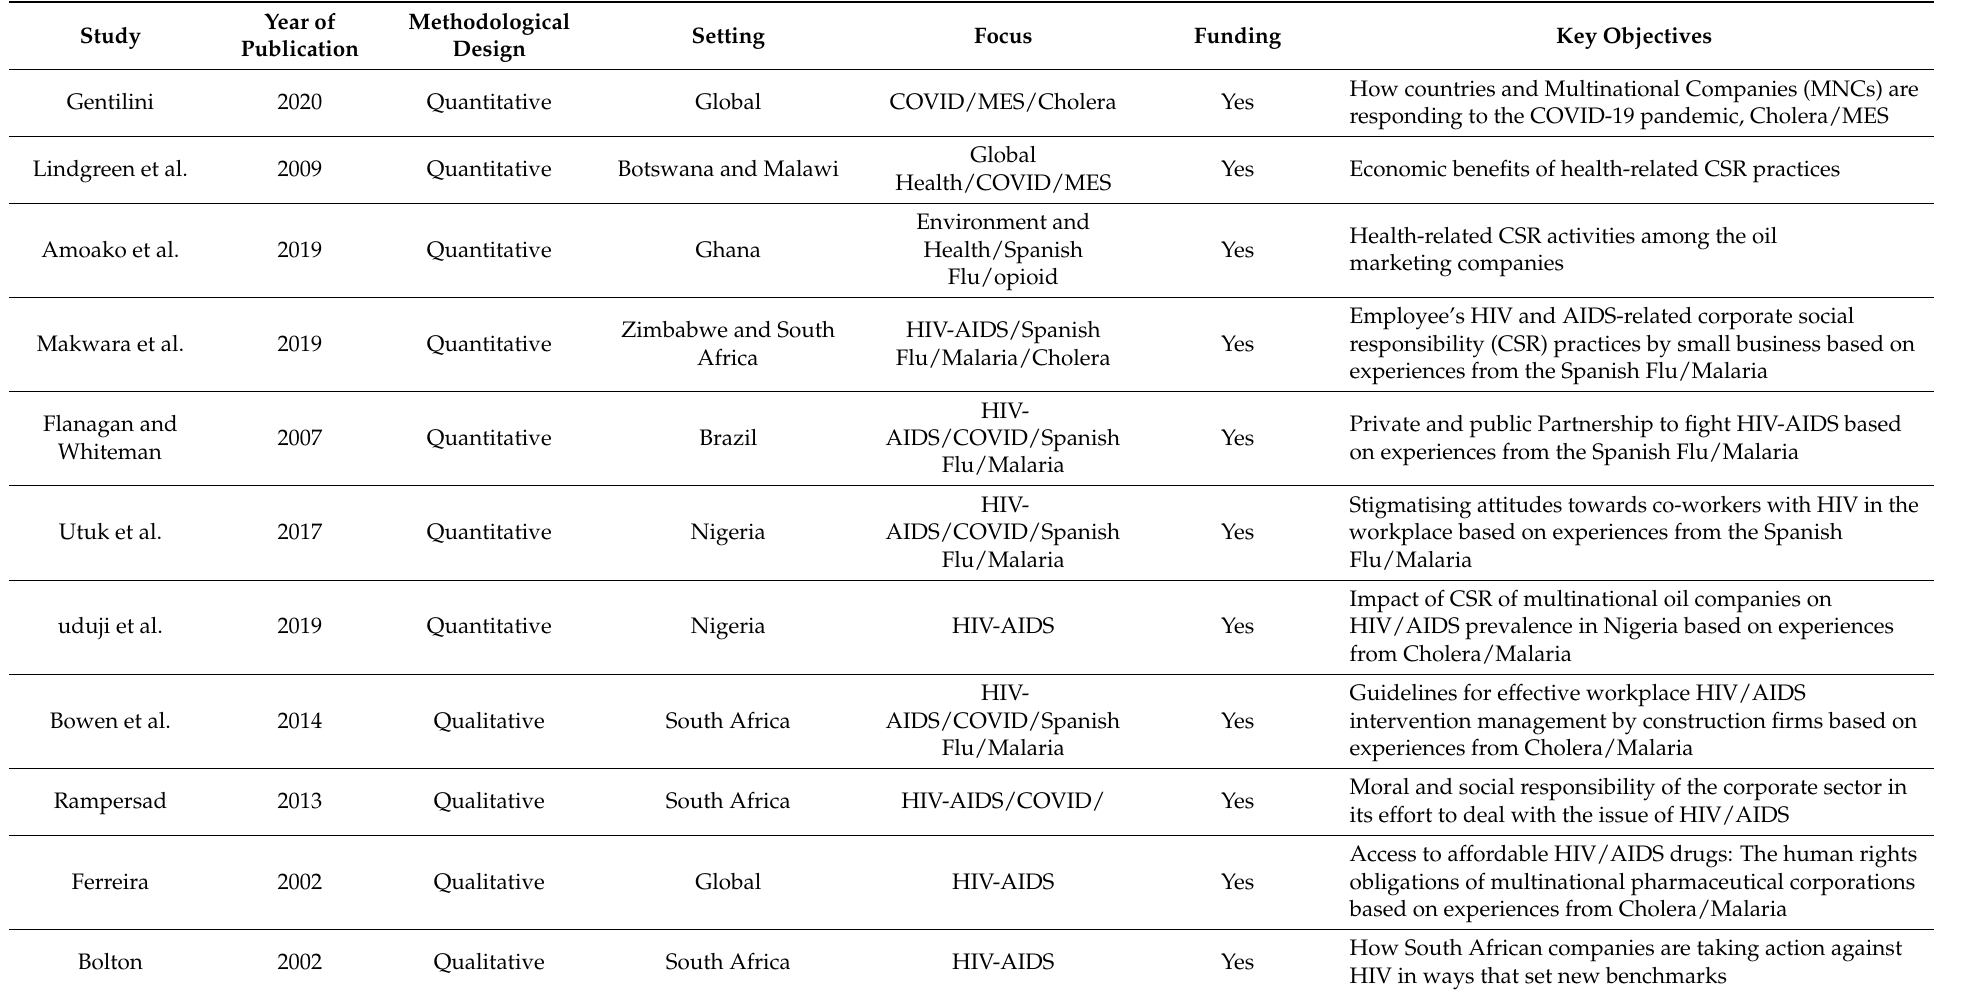
Table 2. Descriptive characteristics of extracted articles for systematic